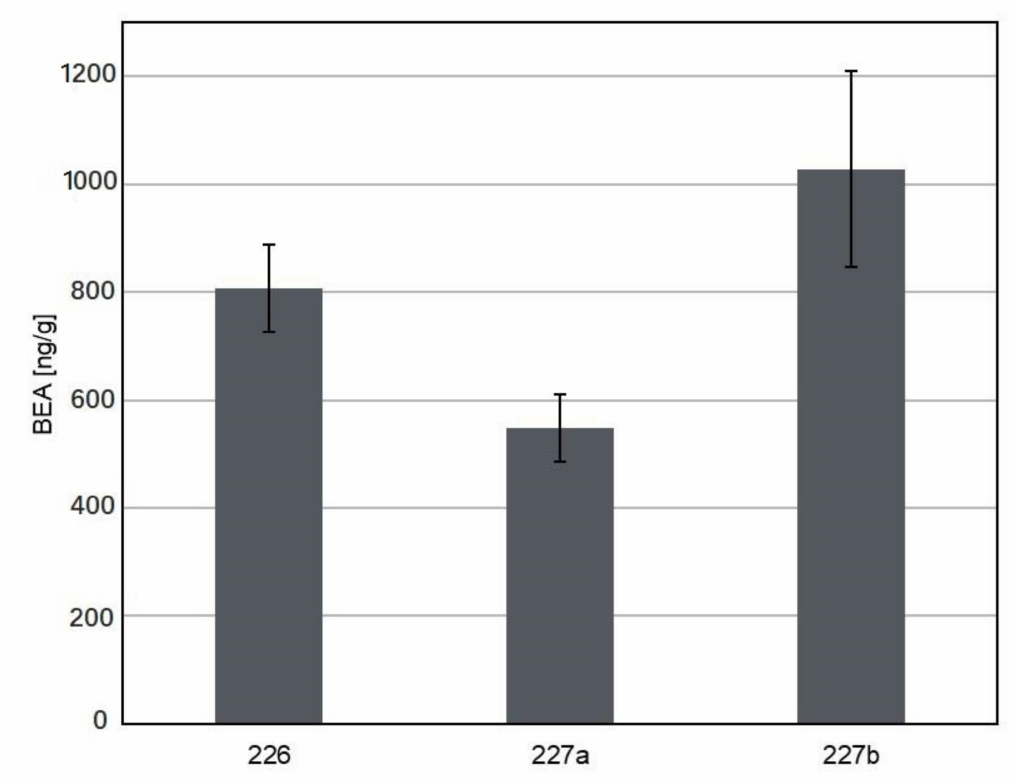
Figure 1. Bauvericin production by S. zeae 226, 227a, and 227b isolates.